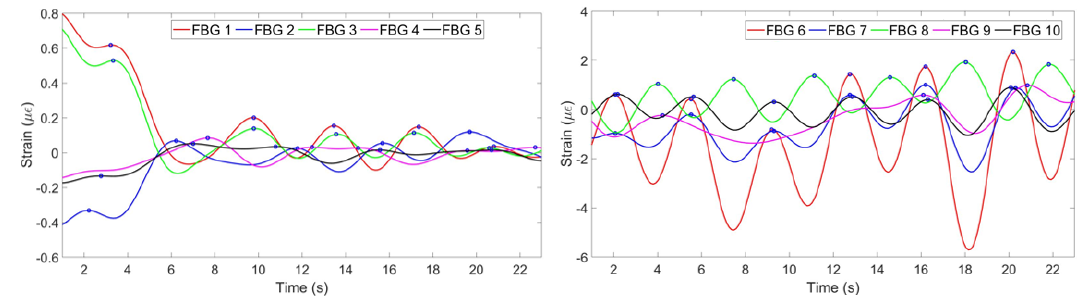
Figure 24. Breathing pattern for the second volunteer in the running position detected by: FBGs on the chest ( left ) and abdomen regions ( right